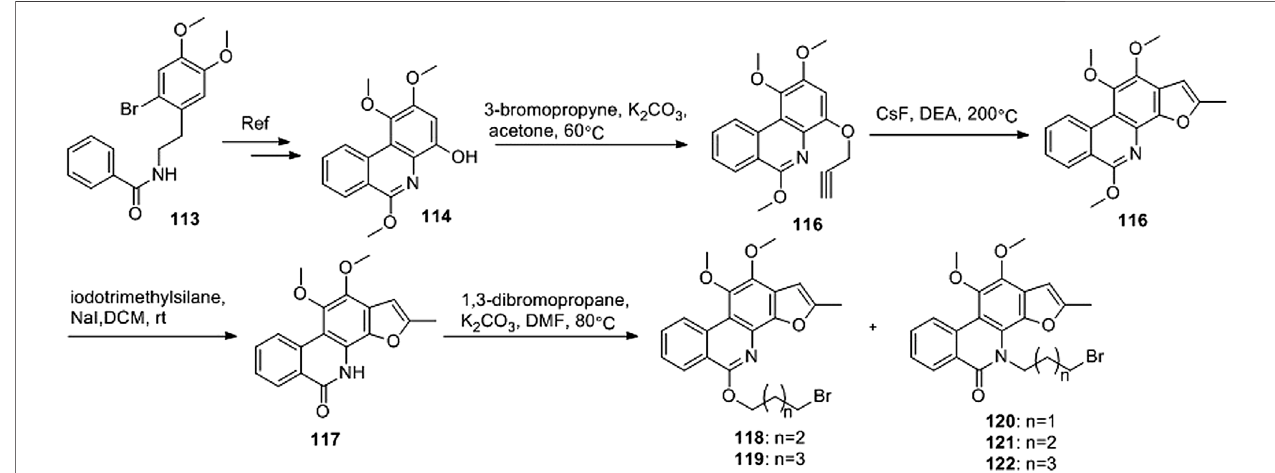
FIGURE 14 | Synthesize the key intermediates 118 – 122